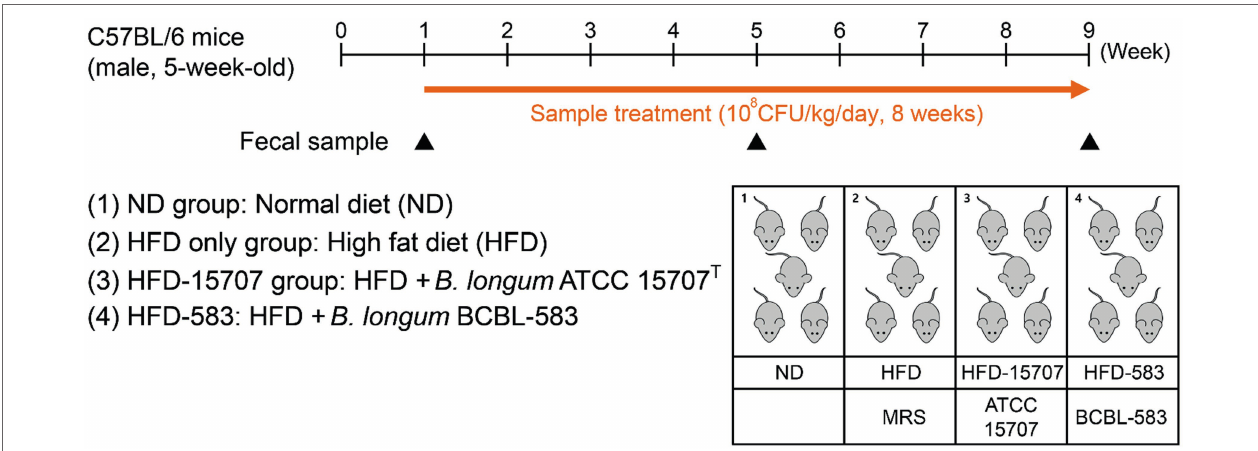
FIGURE 1 | Experimental procedure for high fat diet (HFD) model and administration of bifidobacteria. Mice were given a single week for normal diet (ND) and then randomly divided into four groups. Each bacterial sample was administered orally in the mice (10 8